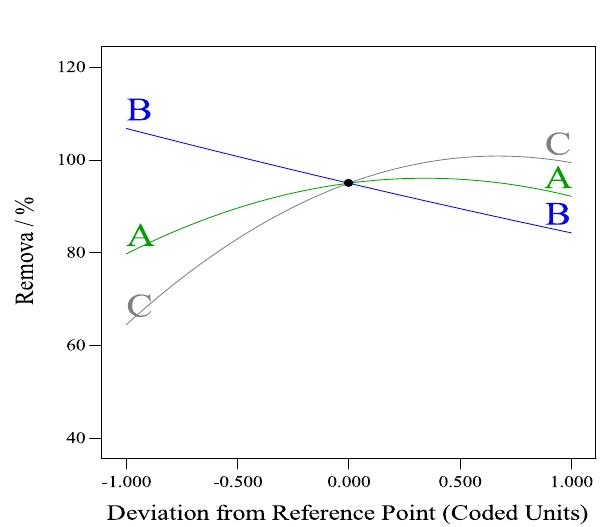
Figure 6. The perturbation